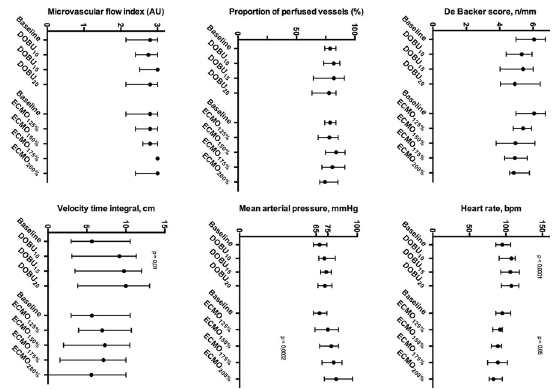
Fig. 1 Flow chart of the